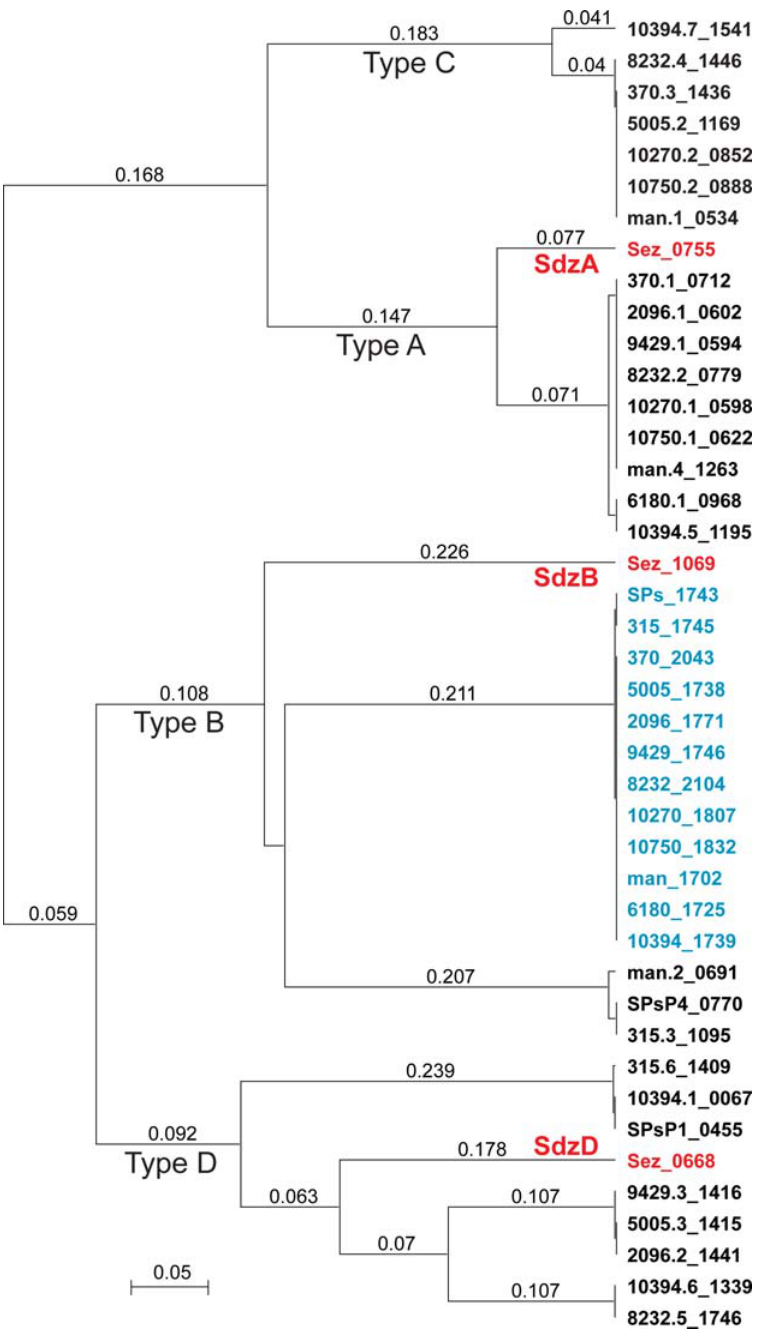
Figure 4. DNases genetic relationships. Inferred products of all of the DNase genes present in the genomes of the 12 sequenced GAS strains, chromosomally encoded (shown in blue) and prophage encoded (shown in black) were aligned with the those present in the S. zooepidemicus MGCS10565 genome (shown in red) and genetic relationships were inferred using the unweighted pair group method with arithmetic mean (UPGMA). Each of the S. zooepidemicus DNases is an outlier relative to the GAS DNases of the same type, arguing for an independent evolutionary path and against very recent horizontal transfer between the species.